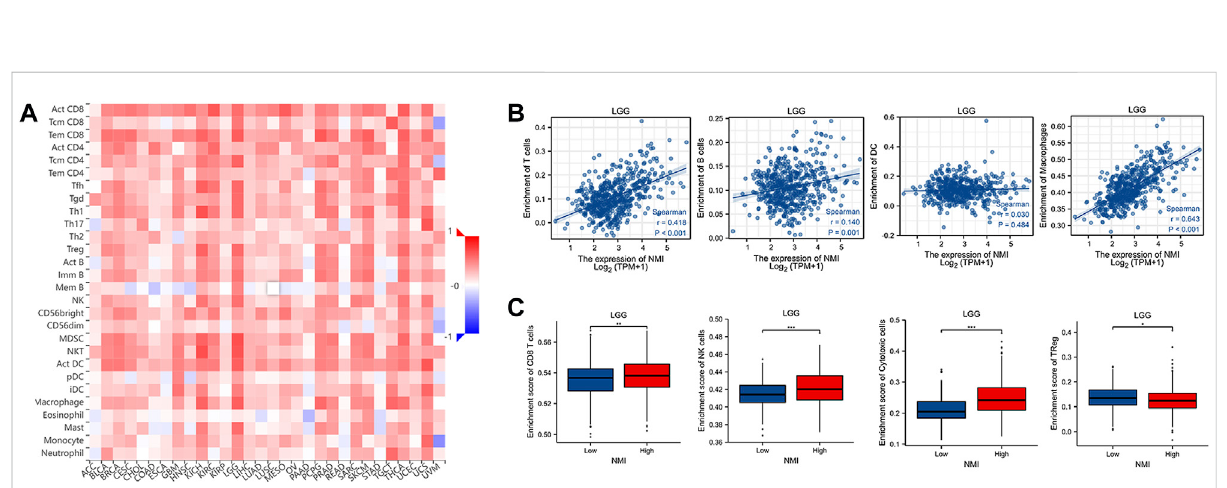
FIGURE 8 Correlation betweenNMI expression and immune cell in fi ltration. (A) The correlation heatmap betweenNMI expression at thepan cancer level and 28 immune cell subtypes was obtained from the TISIDB database. (B) Scatter plot of the correlation between NMI expressionand Tcells, B cells, DCs and macrophages in LGG. (C) In LGG, the correlation box diagram of NMI expression with CD8 + T cells, NK cells, cytotoxic cells and Treg cells. * p < 0.05, ** p < 0.01, *** p <